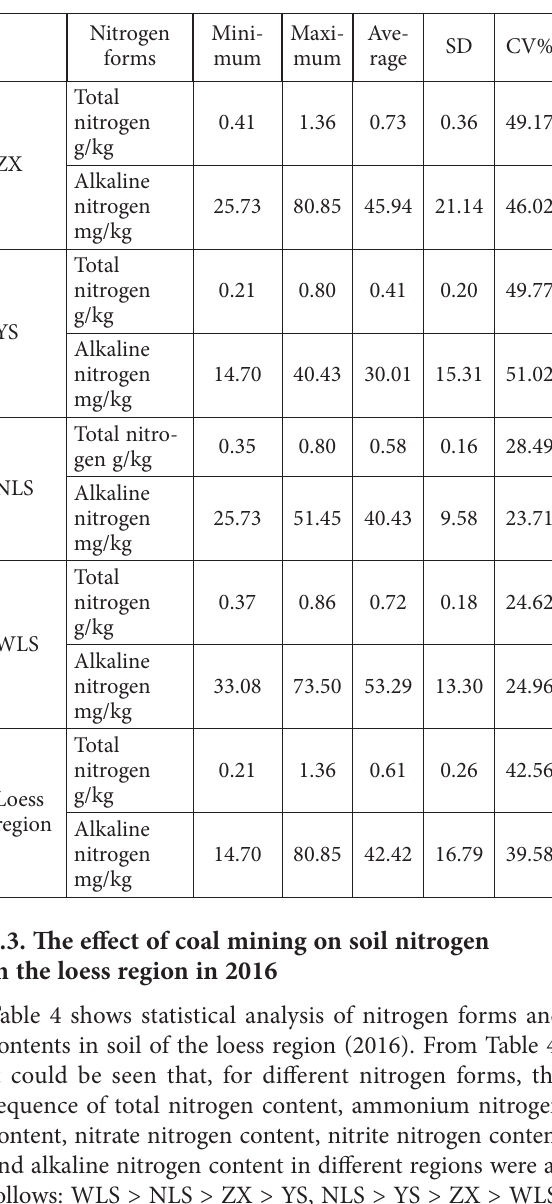
Table 3. Statistical analysis of nitrogen forms and contents in soil of the loess region